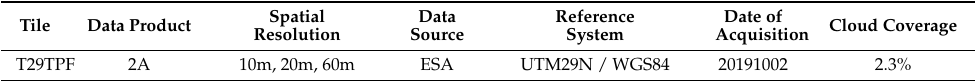
Table 1. Downloaded Sentinel-2 satellite image data over the study